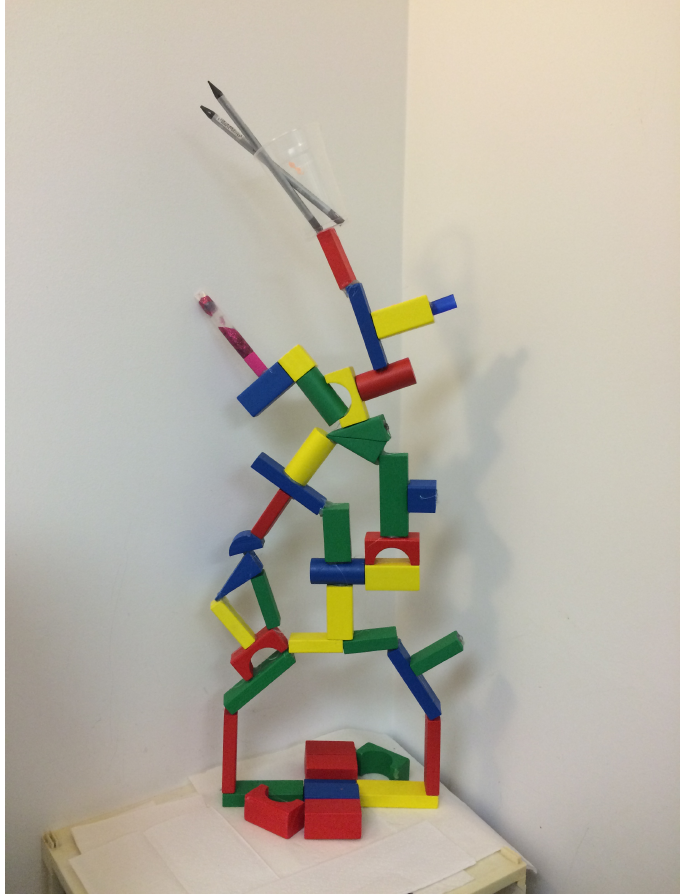
Figure 8 Figure 8. Building together something new (with dad). Wooden. blocks, glue gun, pencils, glitter